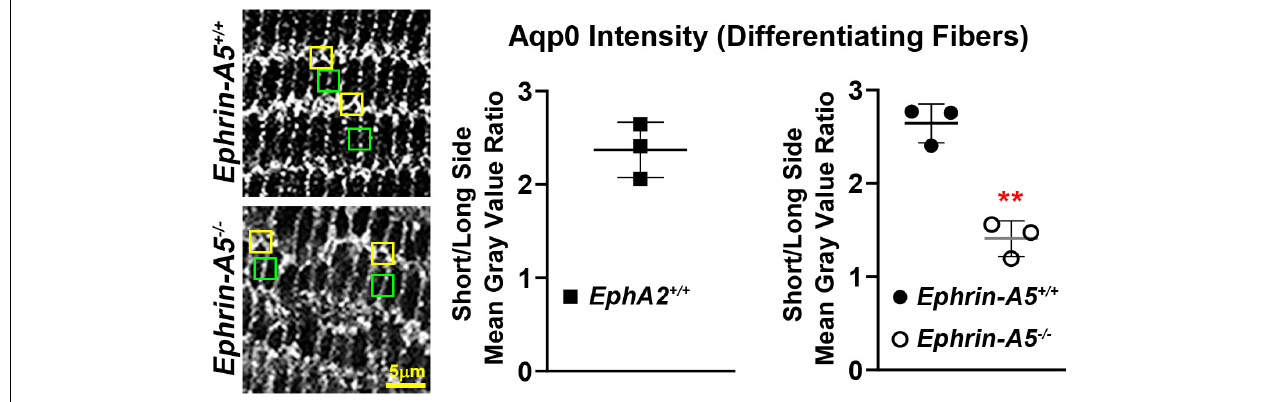
FIGURE 5 | Comparison of the intensity of the Aqp0 immunostaining signal between the long and short sides of differentiating lens fiber cells. Quantification was performed by measuring the mean gray value of at the short side (yellow boxes) and the neighboring long side of the same cell (green boxes). Measurements were made in three different lens sections from each genotype. Immunostaining signal from EphA2 − / − mature lens fibers could not be measured as the cell shape is irregular, and the long and short sides of the cells could not be reliably distinguished. In control ( EphA2 + / + and ephrin-A5 + / + ) mature lens fibers, the ratio of mean gray value (intensity) between the short and long side of the cell was over 2.5, indicating a stronger Aqp0 staining signal on the short side of the cell compared to the long side. In contrast, the ratio of intensity is just above 1 in ephrin-A5 − / − , suggesting that Aqp0 staining intensity was similar between the short and long sides of these KO cells. Scale bar, 5 µ m. **, p <